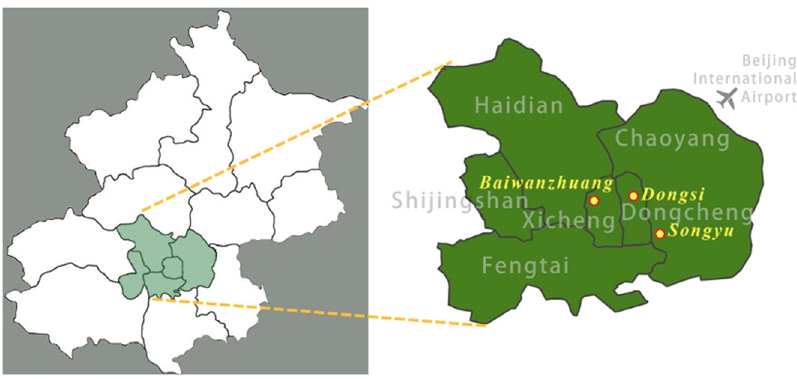
Figure 2. The map of Beijing and the location of three neighborhoods (by author).